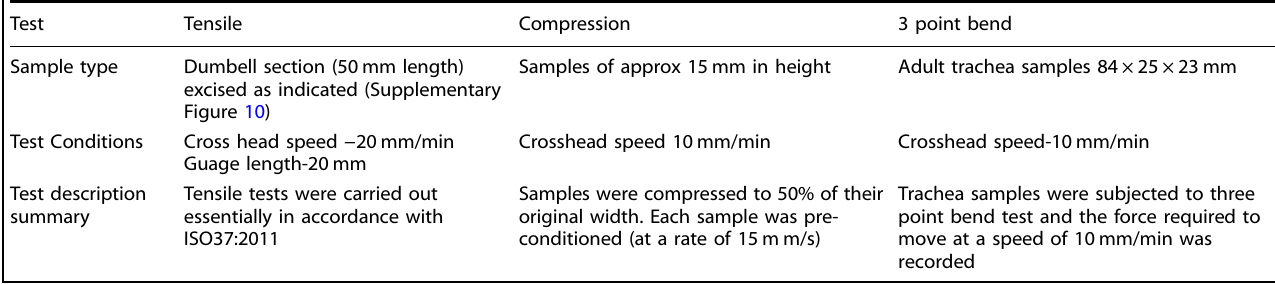
Table 2. Details of sample types and test settings of respective biomechnical evaluations Test